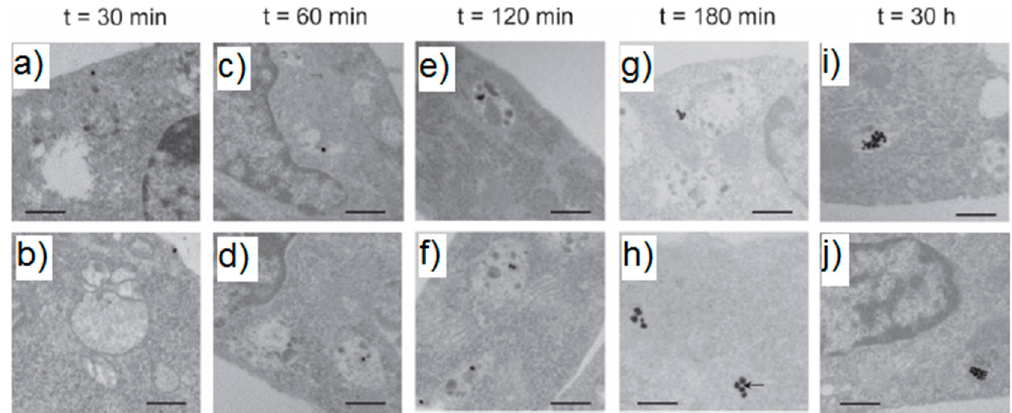
Figure 49. Transmission electron micrographs of immortalized rat renal proximal tubule (IRTP) cells at di ff erent incubation times (the same time points of the SERS micro-spectroscopic data, reported in Figure 48). The black, electron-dense spots, visible in the cells, are the gold nanoparticles. The nanoaggregates size varies with incubation time. After 30 min ( a , b ) and 60 min ( c , d ) aggregates are not evident. After 120 min ( e , f ), nanoclusters of 2–3 particles are visible; after 180 min ( g , h ), 4–6 particles and larger lysosomal nanoaggregates during overnight incubation ( i , j ) of the cells are formed. After 180 min the interparticle distance (see black arrow in panel ( h )) is greater, likely because of the enclosure of the particles in multivesicular structures. Scale bars ( a – g , i , j ): 500 nm; ( h ): 250 nm. Reproduced with permission from Kneipp et al. [454]. Copyright (2006), the American Chemical Society.